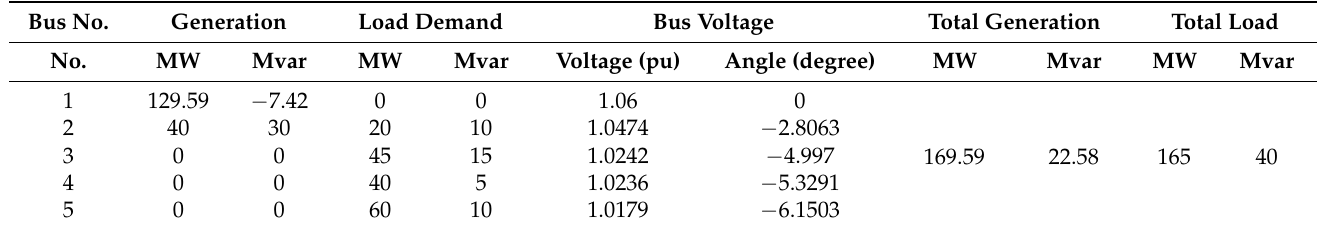
Table 1. Load flow results of the IEEE 5 bus system.